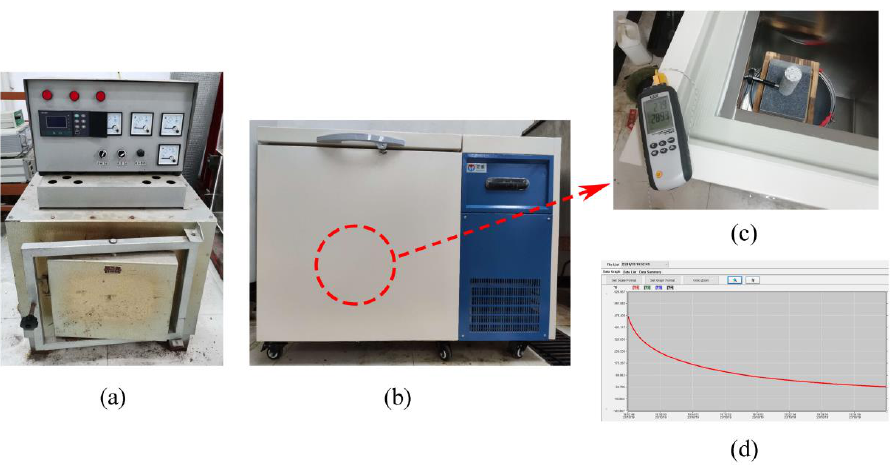
Figure 3. Thermal shock treatments: ( a ) box-type electric furnace; ( b ) ultra-low temperature freezer; ( c ) cooling process inside the ultra-low temperature freezer with the specimen temperature measured by the contact thermocouple thermometer; ( d ) the obtained temperature data during